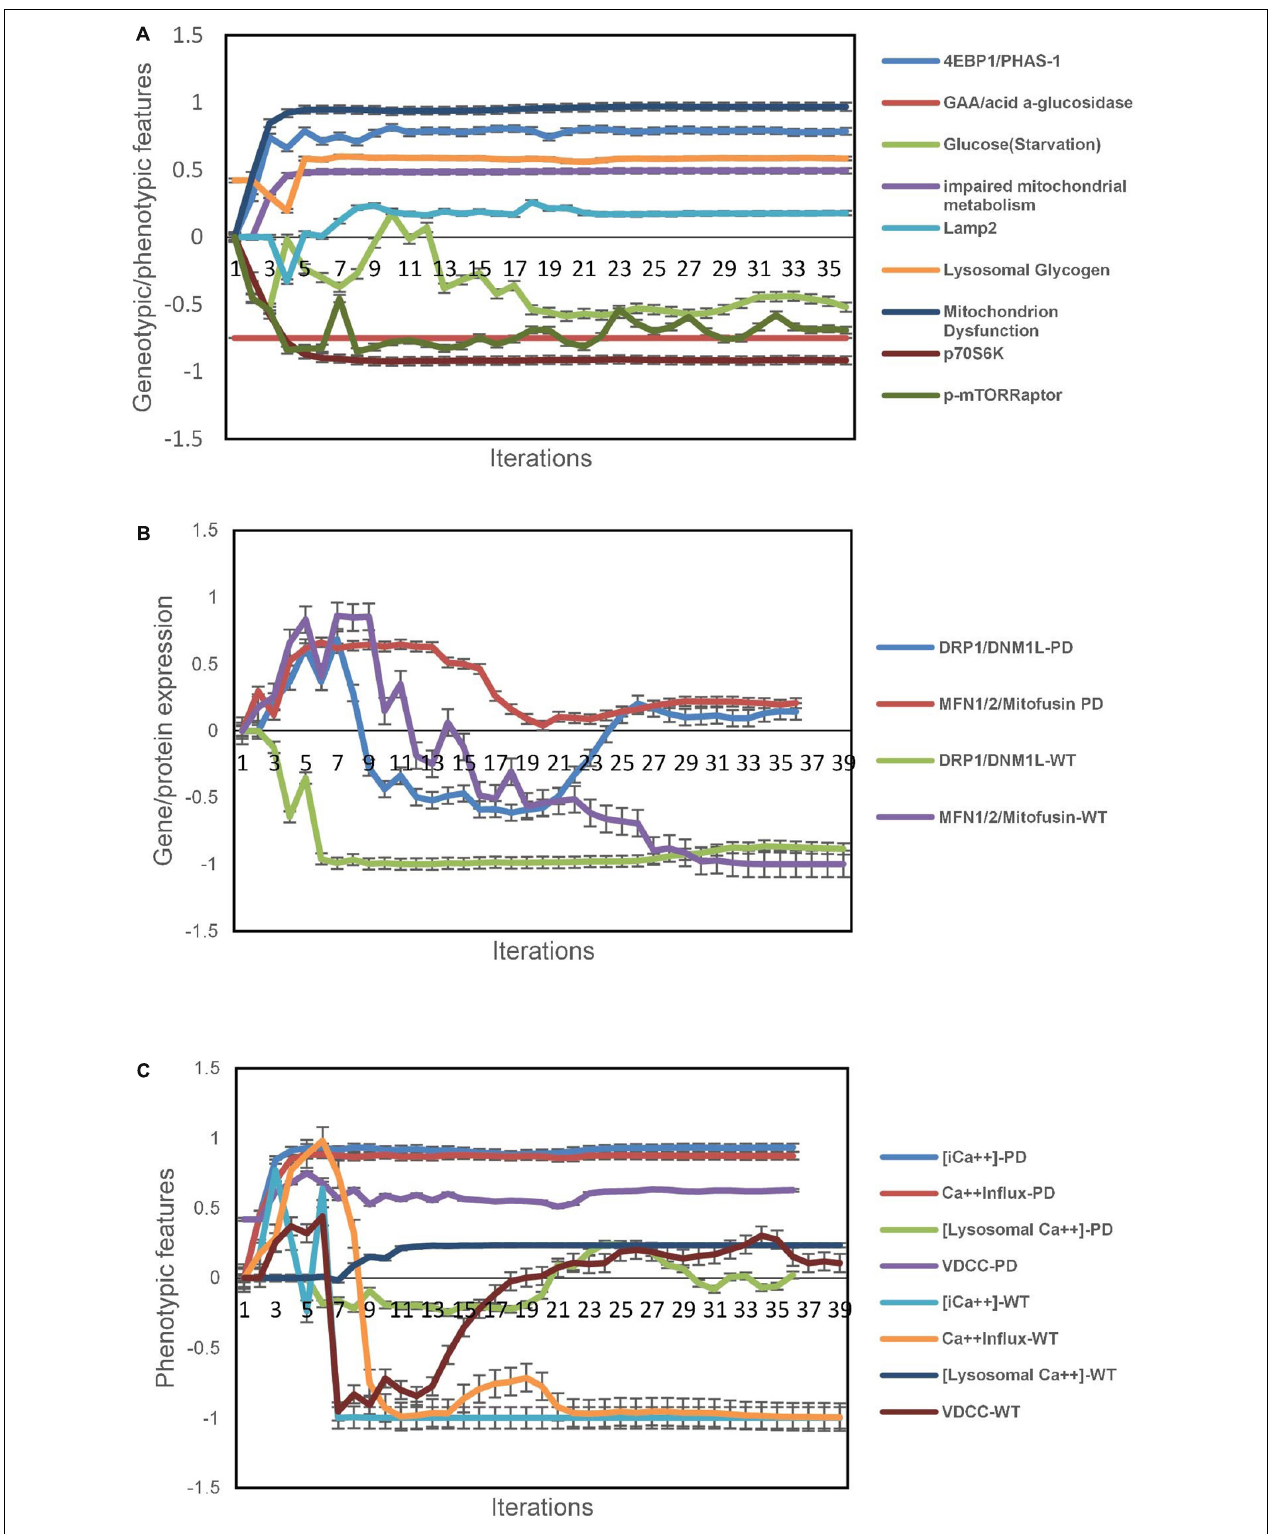
FIGURE 2 | IOPD aiSkMC simulation predictions. (A) Gene/protein expression and phenotypic features of aiSkMC IOPD simulation. (B) Gene/protein expression of morphological proteins in aiSkMC-IOPD simulation. (C) Calcium homeostasis in the IOPD skeletal muscle simulation. Data are representative of three independent simulation experiments; e rror bars indicate ±